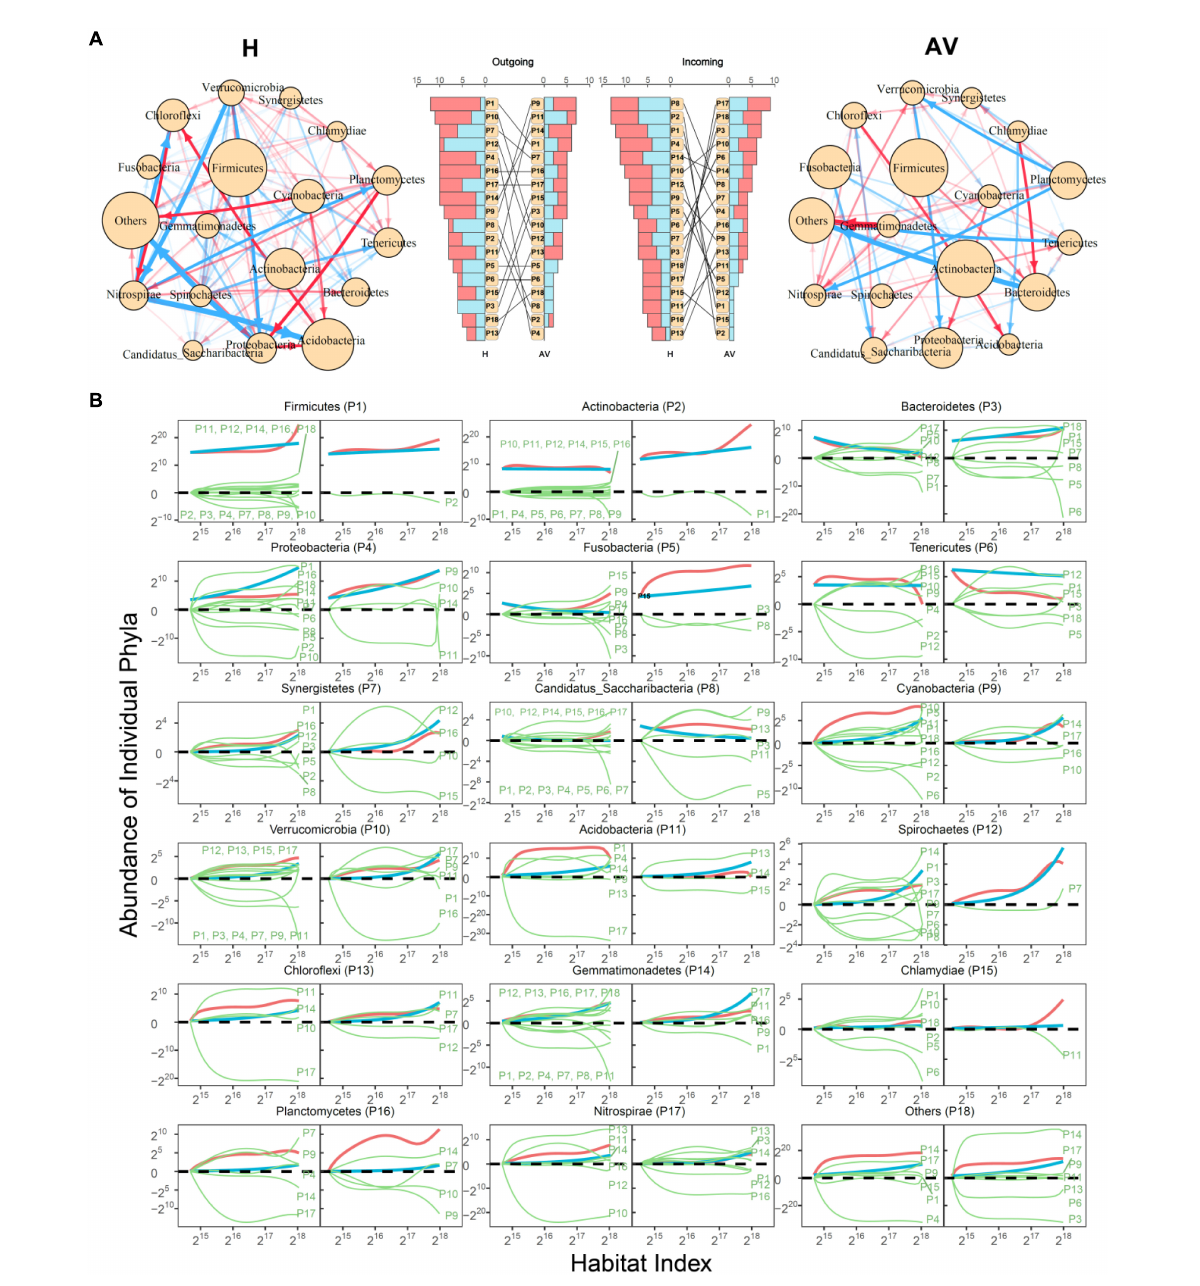
FIGURE4 Taxonomic idopNetworks at the phylum level. (A) Network architecture showing the difference between healthy (H) and AV groups. Red and blue lines denote promotion and inhibition, respectively, with line thickness proportional to the strength of interactions. In the middle are the distributions of the number of outgoing links (red bars for up-regulation and blue for down-regulation) and incoming links (red bars for up-regulation and blue for down-regulation) across different phyla. (B) Decomposition of the net abundance trajectory (blue line) of each phylum, denoted as P1–P18, into its independent abundance trajectory (red line) and dependent abundance trajectory (green line) in the H group (left panel) and AV group (right panel). The names of phyla that regulate a given phylum are shown in the plot (positive regulators above the zero line and negative regulators above the zero